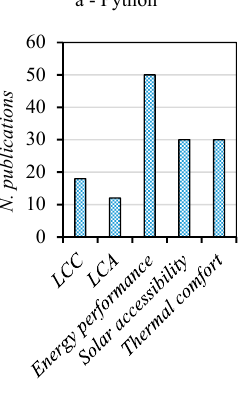
Figure 8. Number of publications for each objective function. Results are presented according to the used programming language: ( a ) Python, ( b ) MATLAB, ( c ) Jave, and ( d ) others.